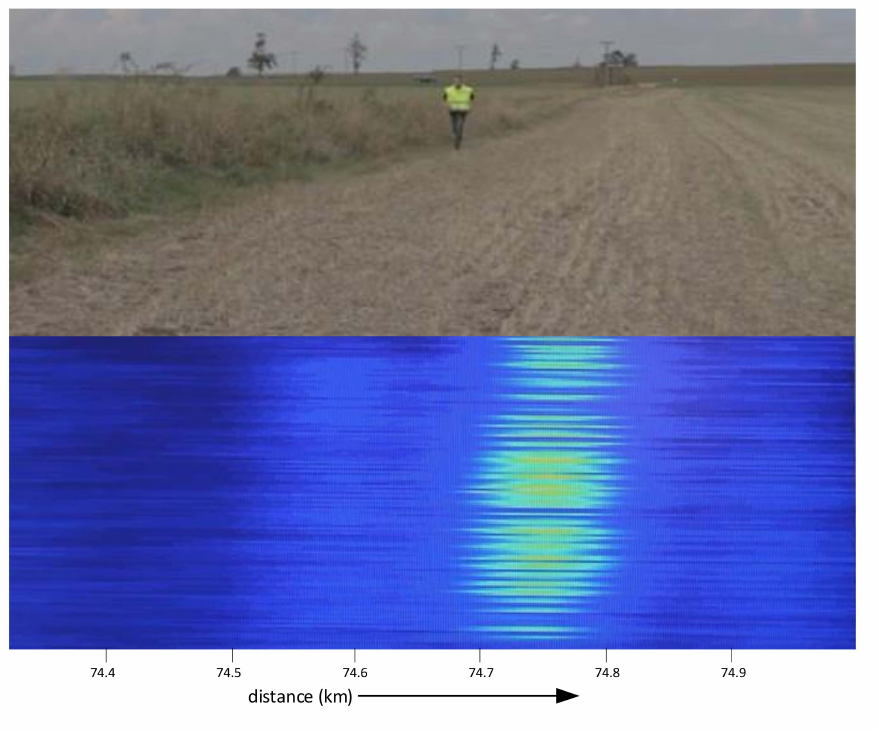
Figure 23. Detection of running person at the distance 74.75 km.